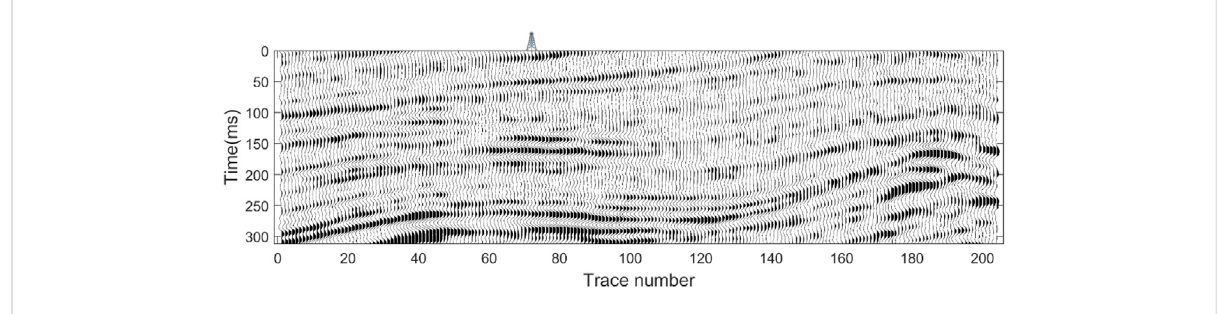
FIGURE 7 Field seismic gather at well location. The well is at trace 73.